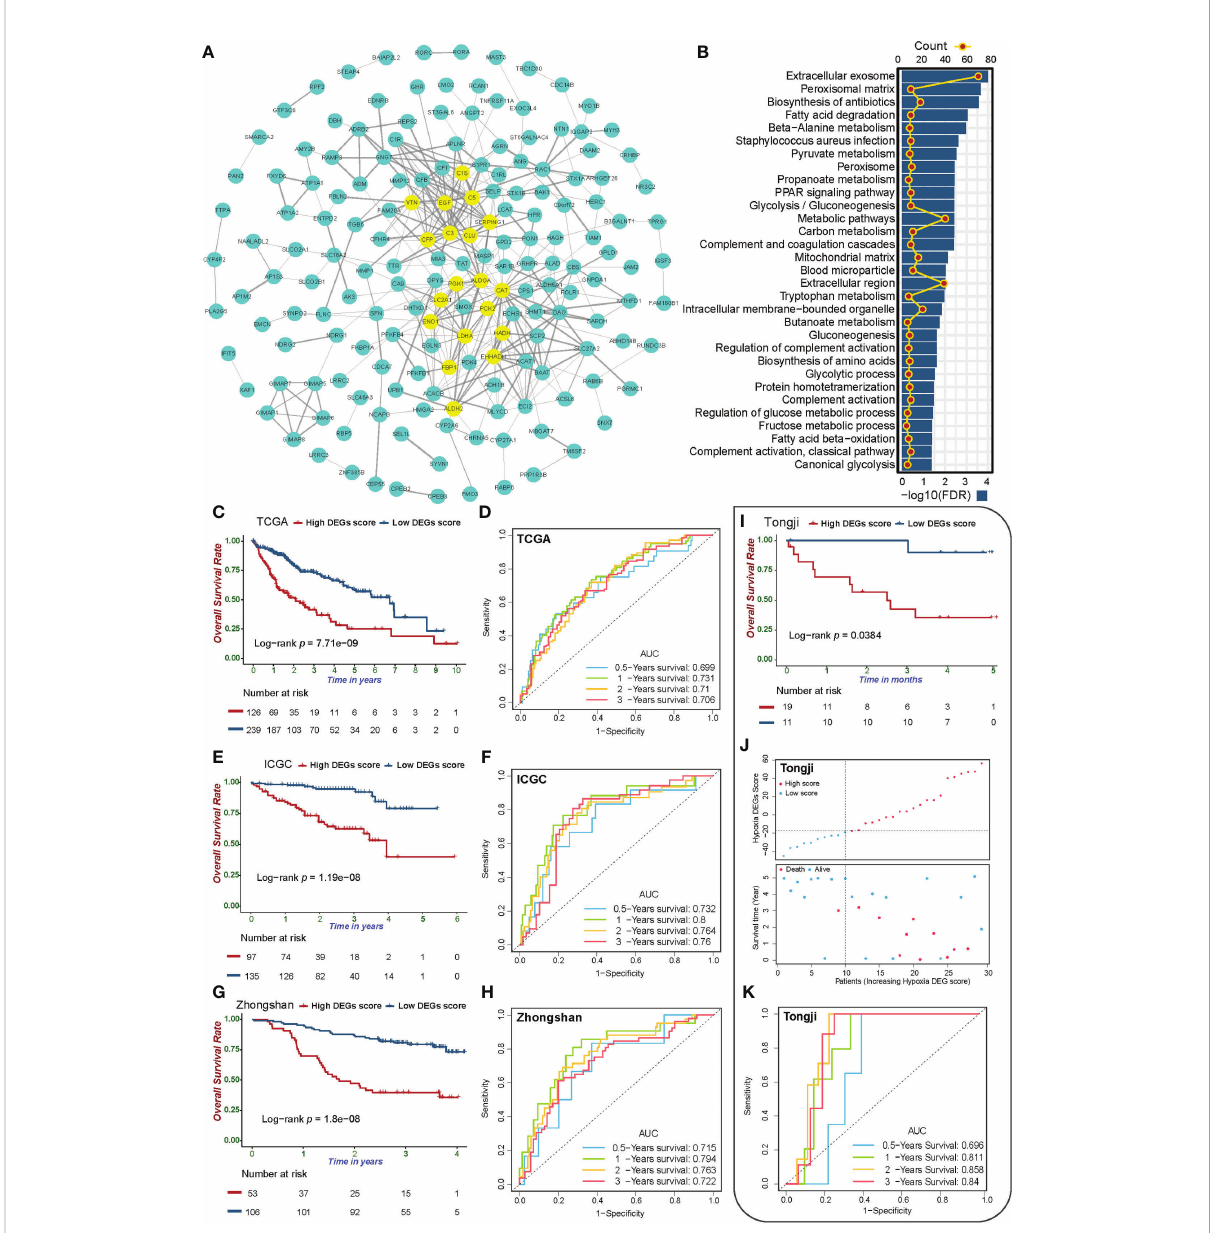
FIGURE 4 Validation of the Hypoxia_DEGs_Score survival prediction value. (A) Protein-protein interaction network of the hypoxia-related DEGs. The thickness of the lines represents the strength of the association, yellow circles represent the hub gene in the PPI network, and blue represents non-hub genes. DEGs with a Degree value greater than the threshold of 12 were considered hub genes. (B) Enrichment analysis for the 251 hypoxiarelated DEGs based on KEGG and GO term analysis. (C, E, G, I) Kaplan-Meier survival curves showing differences in overall survival between high and low Hypoxia_DEGs_Score groups in the TCGA-LIHC (C) , ICGC-LIRI-JP (E) , Zhongshan (G) , and Tongji (I) cohorts. (D, F, H, K) ROC analysis of 0.5-, 1-,2- and 3-year OS demonstrating the outstanding prognostic value of Hypoxia_DEGs_Score in the TCGALIHC (D) , ICGC-LIRI-JP (F) , Zhongshan (H) , and Tongji (K) cohorts. (J) Scatterplots of survival status and risk curves sowing the prognosis and Hypoxia_DEGs_Score values of patients in the Tongji